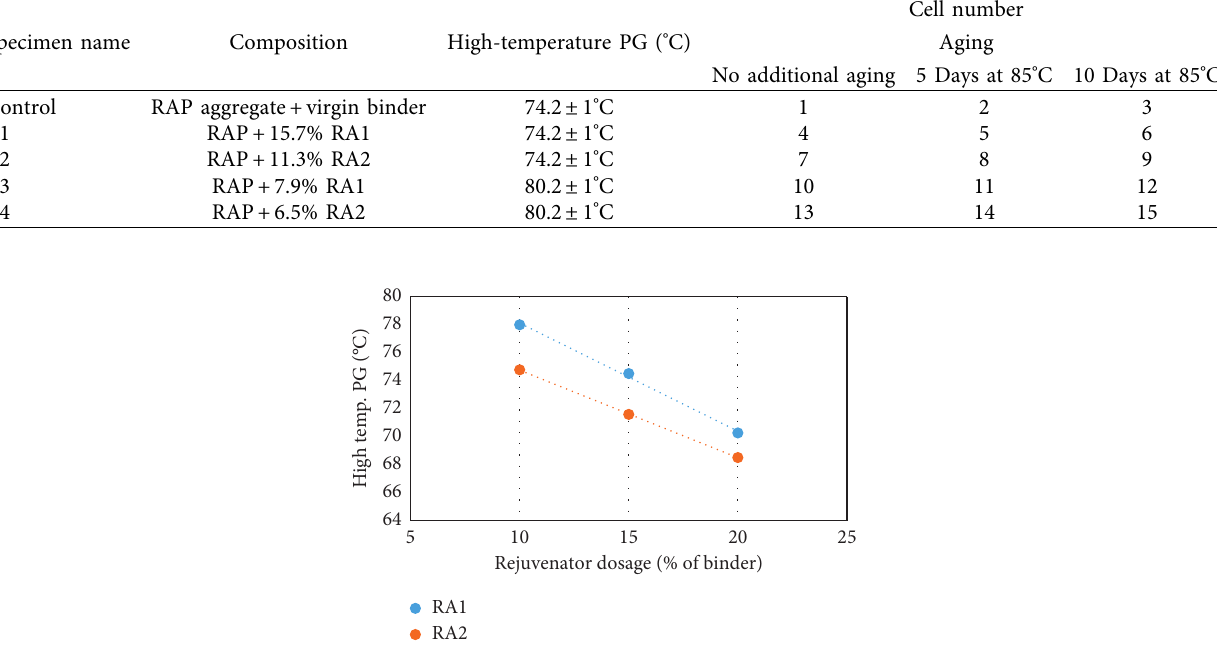
Figure 1: Softening curves of rejuvenators. Table 4: Composition and volumetric properties of the rejuvenated specimens.